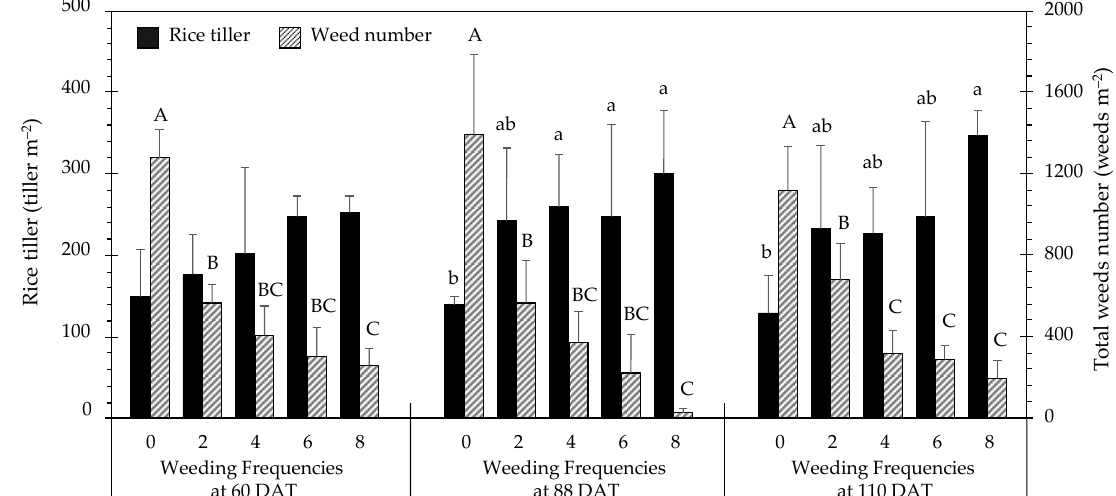
Figure 1. Effect of weeding frequencies on rice tiller and total weed number at 60, 88, and 110 DAT (days after transplanta- tion). Rice tiller was expressed as tiller number per m 2 , while weed number was expressed as weed number per m 2 . Bars indicate standard deviation ( n = 4). Values followed by different letters are statistically different within sampling time at p < 0.05 based on Tukey’s HSD test. Significant differences for rice tiller are followed by small letters, while total weed numbers are followed by capital letters. The intervals of mechanical weeding until 49 DAT were 0, 2, 4, 6, and 8.